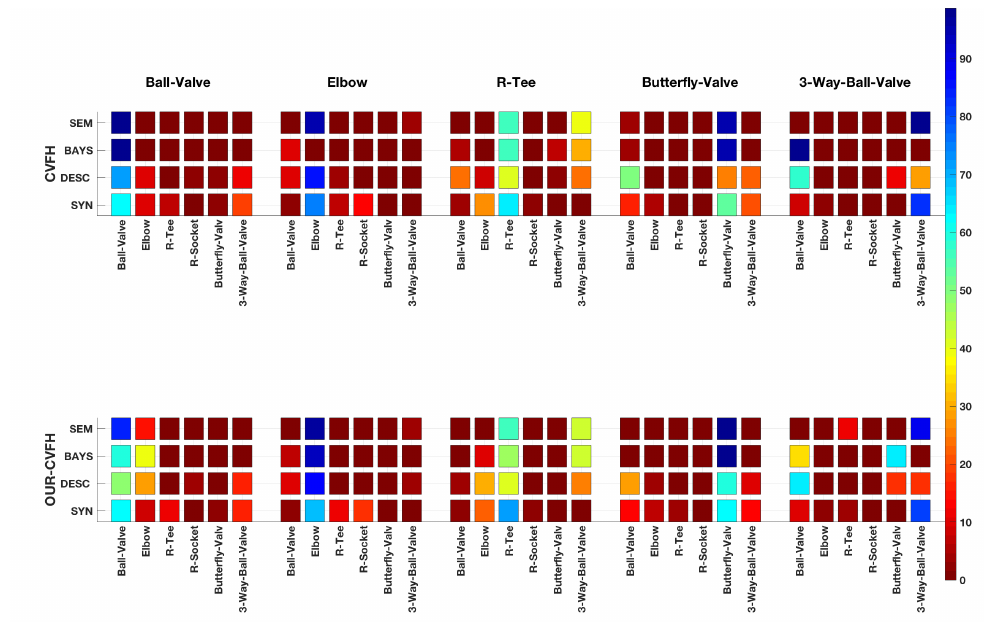
Figure 13. Graphical representation of the Confusion Matrices.